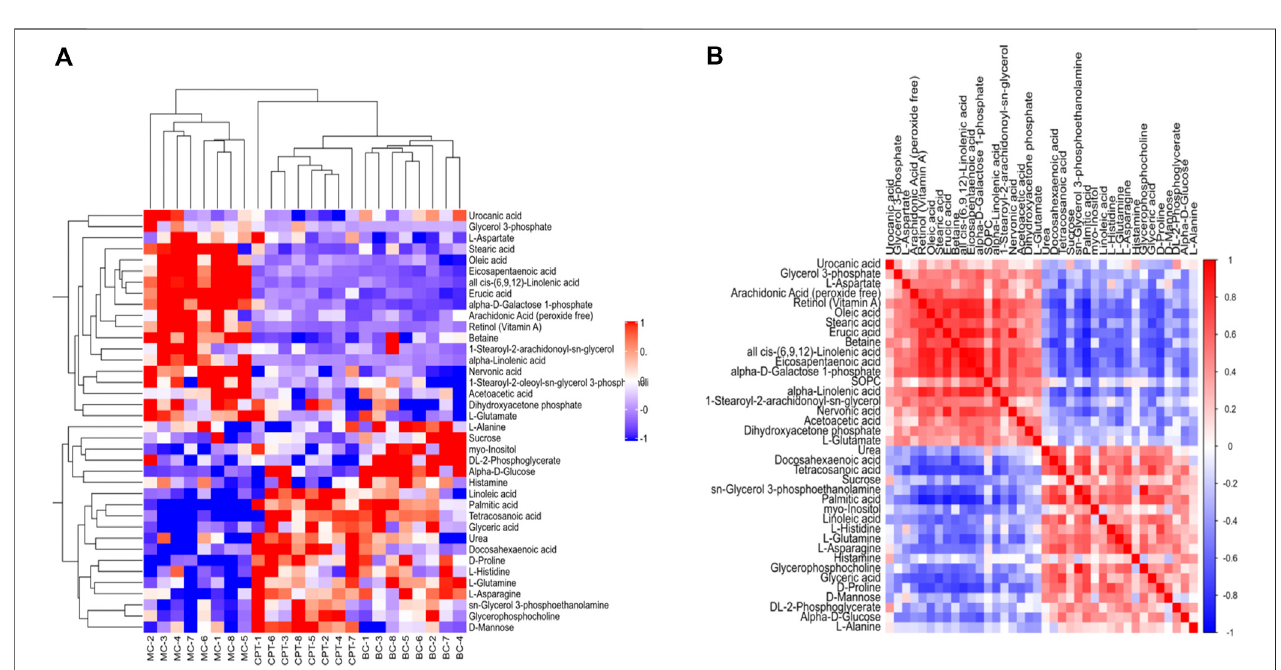
FIGURE 6 | The multivariate analysis of skin metabolites in positive (ESI+) and negative (ESI − ) modes (n (cid:2) 8); 1-XP (the BC group), 2-XP (the MC group), 4-XP (the CPT group) (A) PCA score plots in positive modes of the BC, MC and CPT groups. Samples in BC and CPT groups were separated from the MC group; ESI+: R 2 X (cid:2) 0.548 (B) OPLS-DA score plots in positive modes of the MC and CPT groups; ESI+: R 2 X (cid:2) 0.559, R 2 Y (cid:2) 0.989, Q 2 (cid:2) 0.944 (C) PLS-DA score plots in positive modesoftheMCandCPTgroups;ESI+:R 2 X (cid:2) 0.559,R 2 Y (cid:2) 0.989,Q 2 (cid:2) 0.962 (D) PCAscoreplotsinnegativemodesoftheBC,MCandCPTgroups;ESI − :R 2 X (cid:2) 0.638 (E) OPLS-DAscoreplotsinnegativemodesoftheMCandCPT groups;ESI − :R 2 X (cid:2) 0.689,R 2 Y (cid:2) 0.986,Q 2 (cid:2) 0.970 (F) PLS-DAscoreplotsinnegativemodesof the MC and CPT groups; ESI − : R 2 X (cid:2) 0.729, R 2 Y (cid:2) 0.997, Q 2 (cid:2) 0.980.